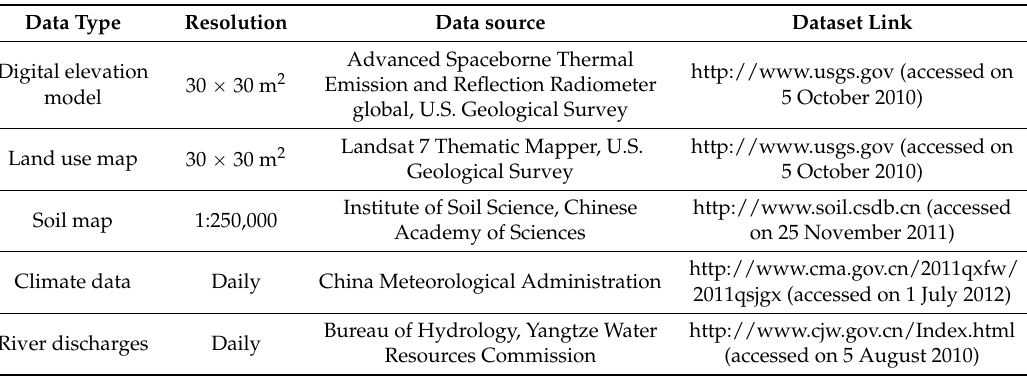
Table 1. Data types, resolution and data